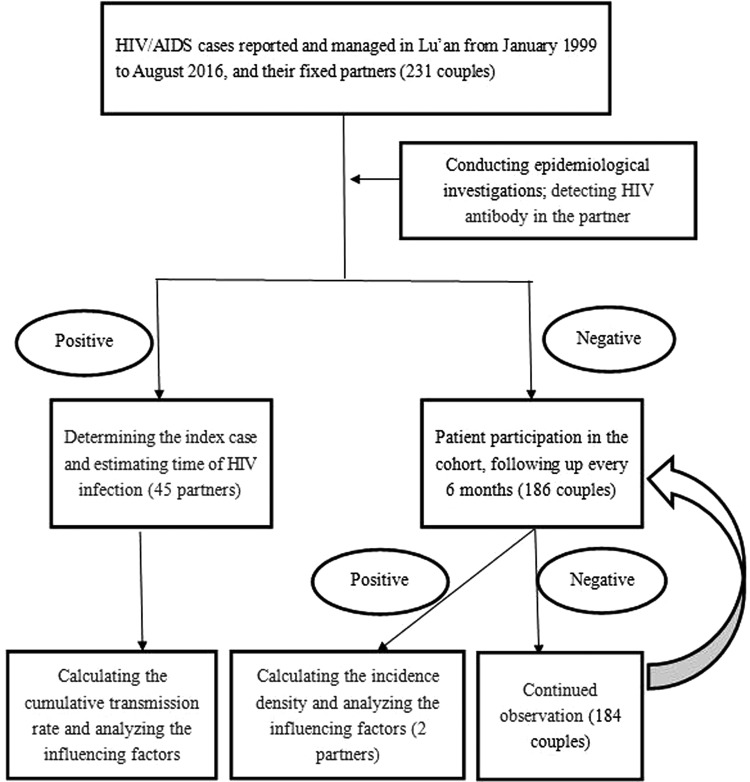
Flowchart of detection and assessment of HIV cases.